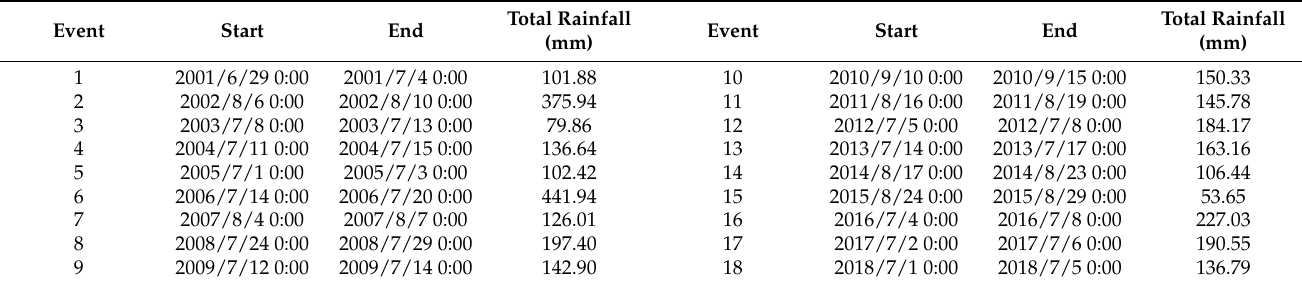
Figure 3. Chungju Dam watershed for study area with two major upstream flows and one combined downstream flow. Table 1. Selected storm events for CJD watershed.